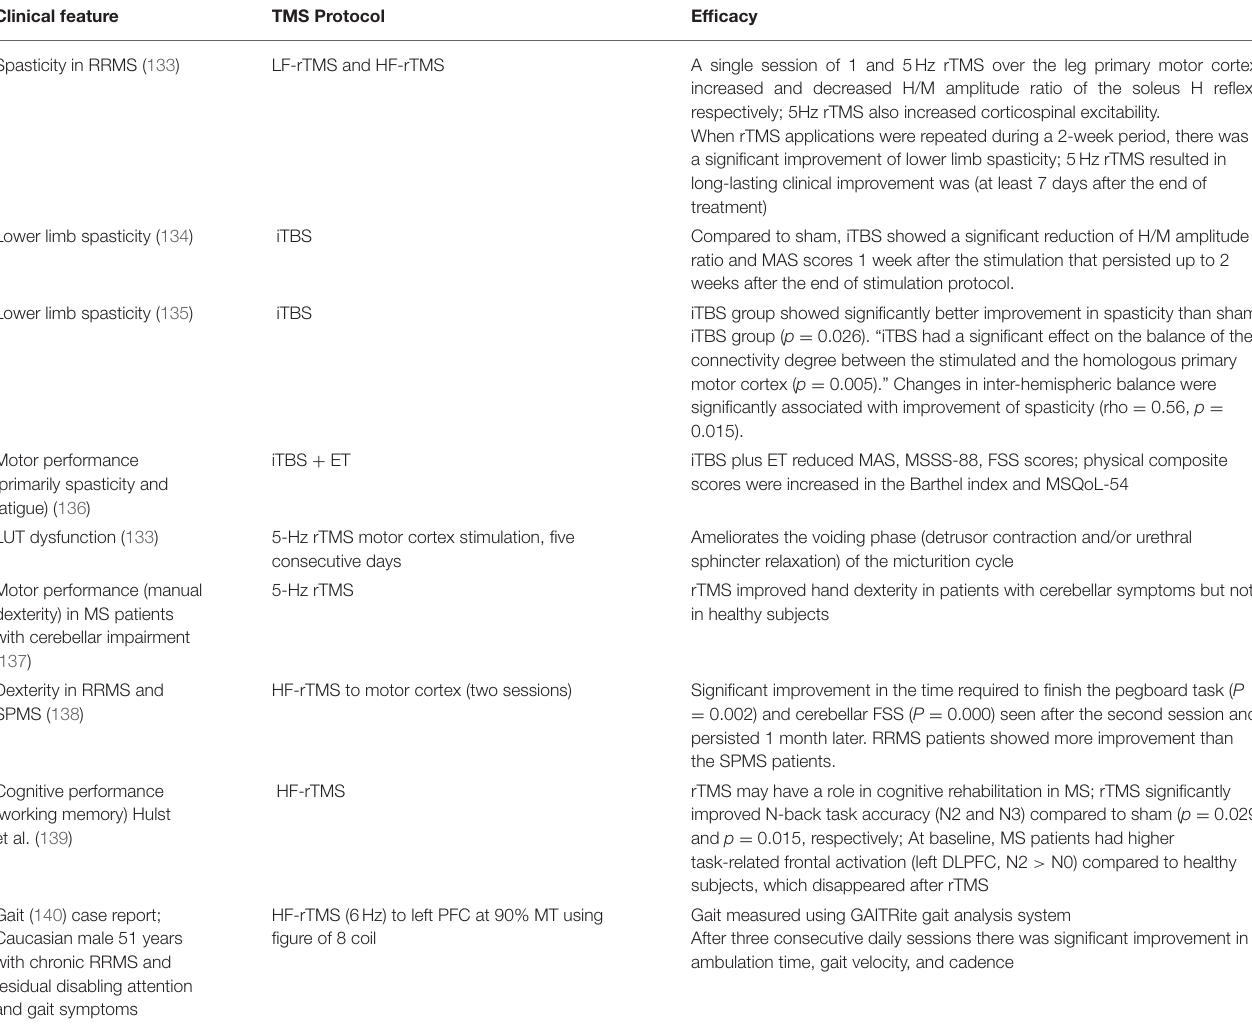
TABLE 5 | TMS in multiple